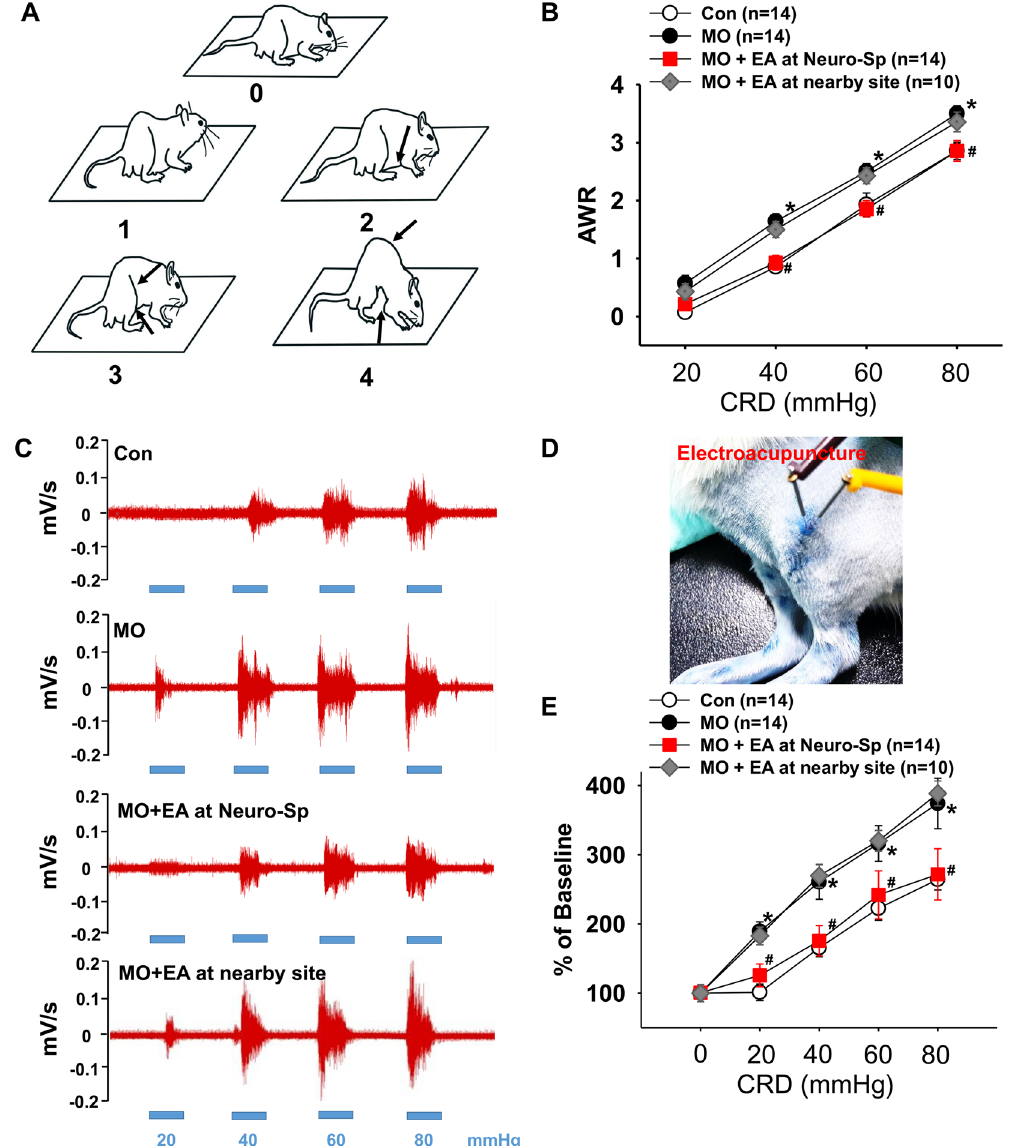
Figure 2. Visceral hypersensitivity and its reduction by electroacupuncture at Neuro-Sps. (A ) Schematic drawings of rats on platforms illustrating the behavioral scale based on visual observations of the AWR in * p < 0.05 vs. Con; # p < 0.05 vs. MO + EA at nearby site. ( C–E ) EMG activities in the external oblique muscle